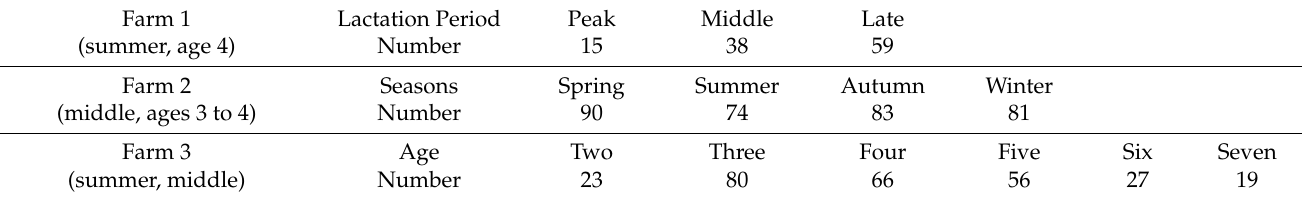
Table 9. The number of cows that received the melatonin treatment on different cattle farms. Farm